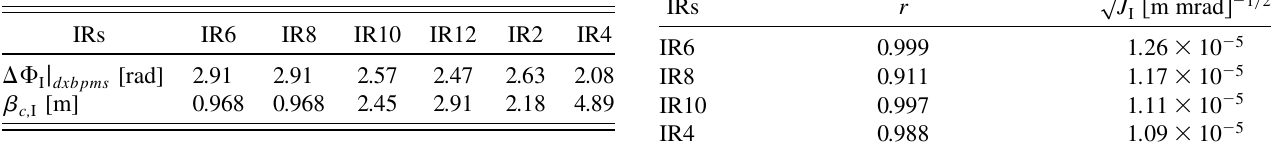
TABLE IV. r and (cid:7)(cid:7)(cid:7)(cid:7) J